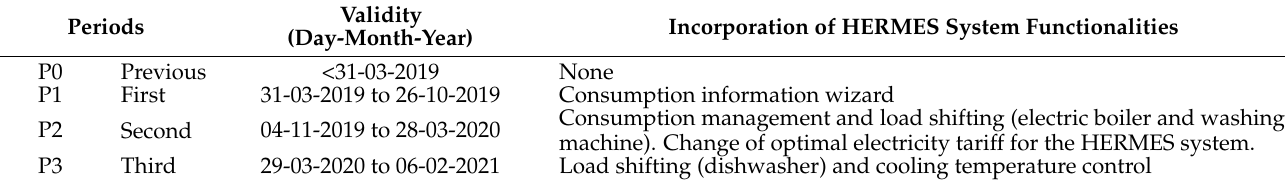
Table 5. Phases of incorporation of HERMES system functionalities.